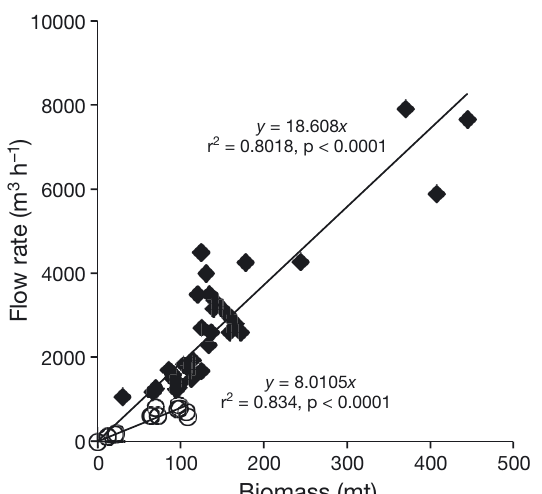
Fig. 2. Relationship between flow rate and standing stock for south coast (filled diamonds) and west coast (circles) abalone ( Haliotis midae) farms. Regressions were formu- lated in SigmaPlot 12.0 and compared using